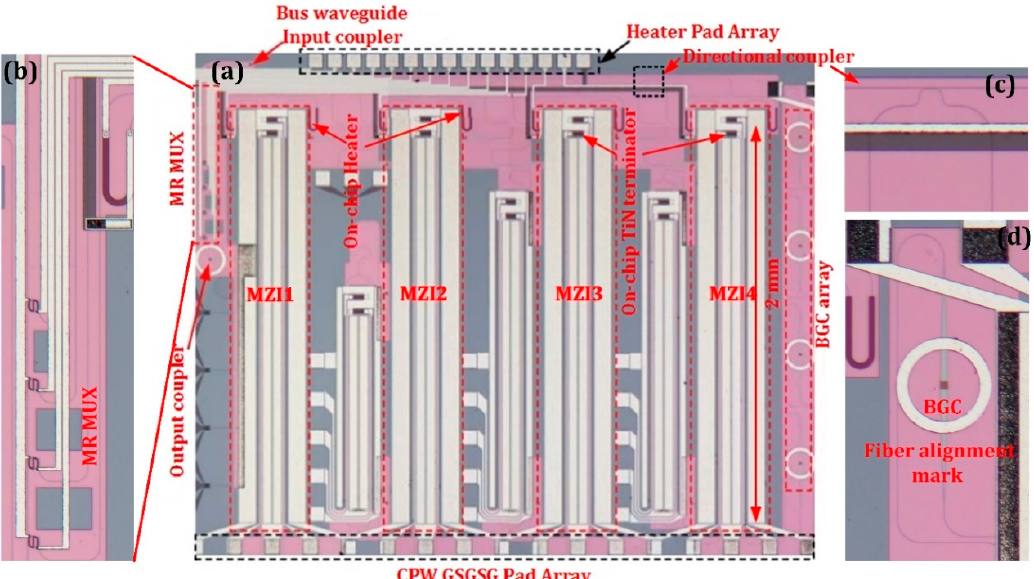
Figure 5. ( a ) Optical micrograph of the WDM transmitter with surface-normal optical interfaces. ( b ) ( b ) The zoom-in picture of the MR Multiplexer. ( c ) The zoomed-in picture of the directional coupler. ( d ) The zoom-in picture of the bidirectional grating coupler-based surface-normal optical